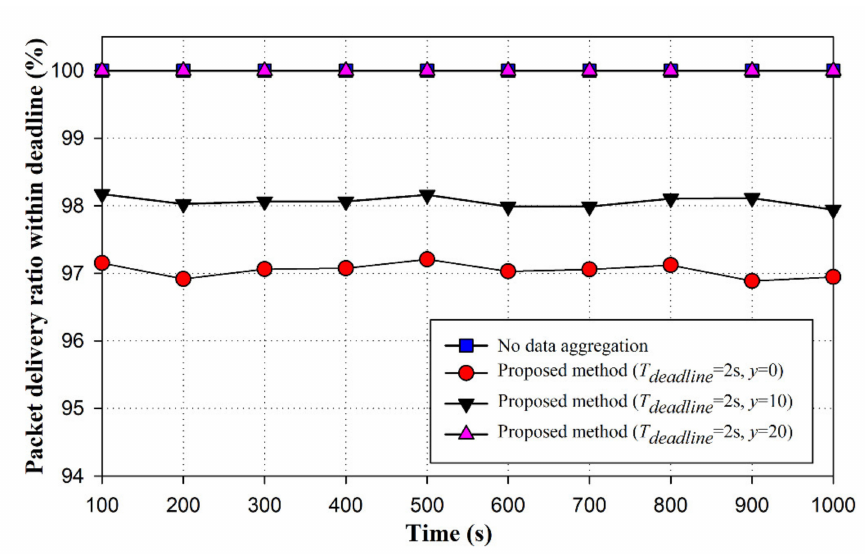
Figure 8. Packet delivery ratio with the deadline of 2 s.